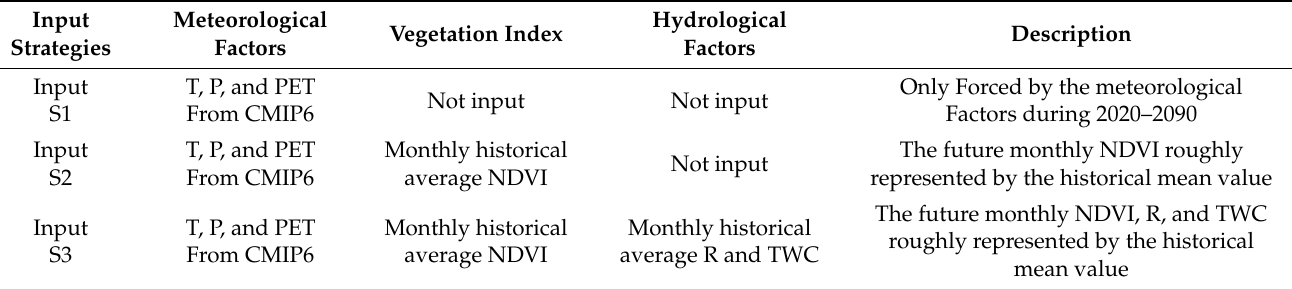
Table 5. Three projection input strategies of AET.